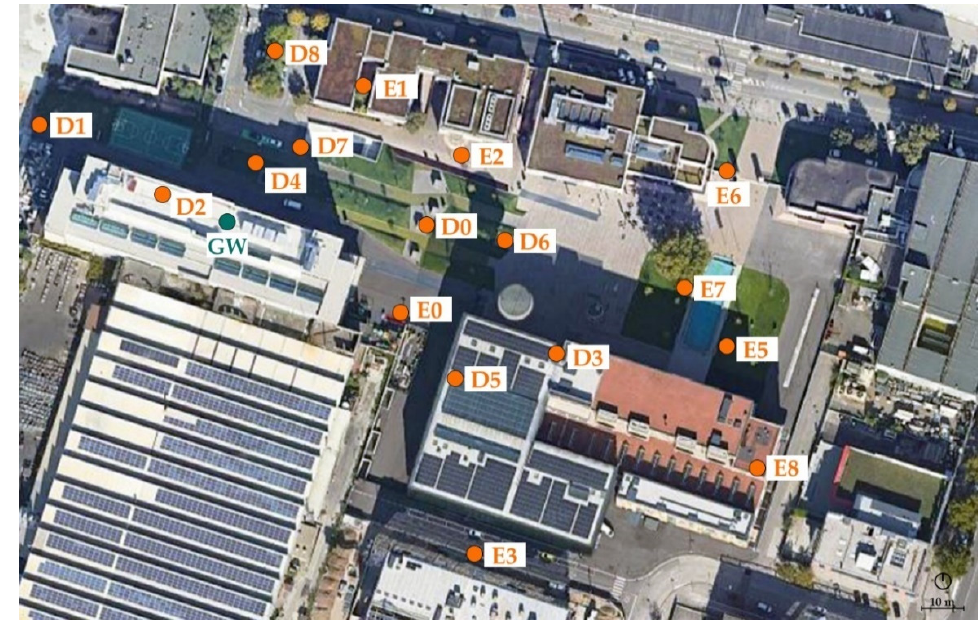
Figure 3. WSN deployment within the NOI Techpark area (Bolzano South): location of sensor nodes (orange) and gateway (GW, blue). Aerial image source: Google Maps.